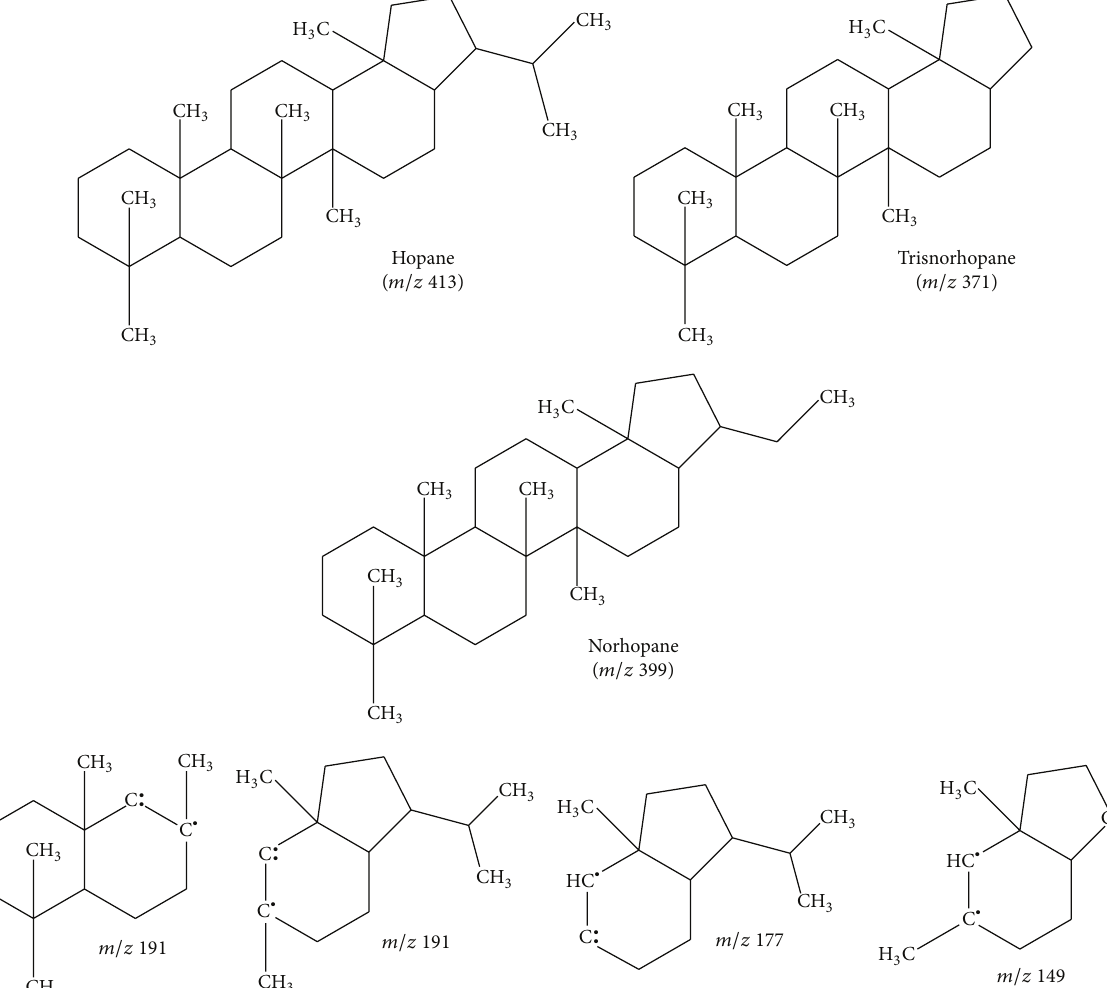
Figure 1: Molecular structures of targeted hopanoid series and possible structures of their fragment